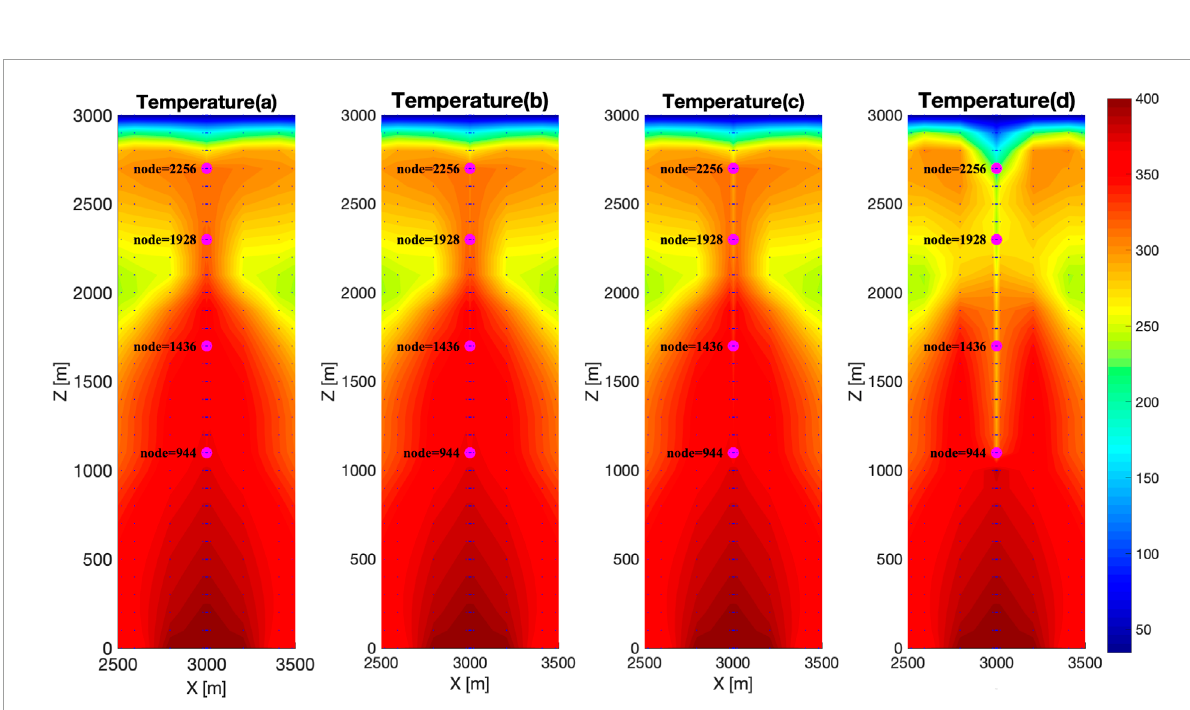
FIGURE 14 Temperature field’s time variation in the Phlegraean Fields with the DBHE in service. Results after 0.9 years (A) , 3 years (B) , 12 years (C) , and 200 years (D) .